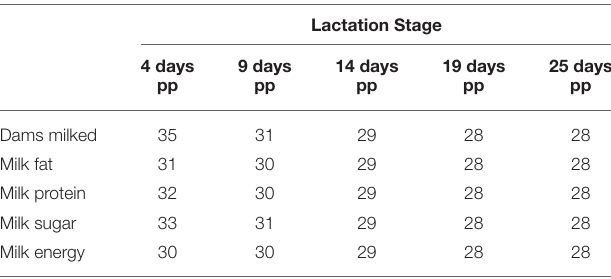
TABLE 1 | Total number of dams milked and number of milk samples assayed for proximate composition at each lactation stage. Lactation